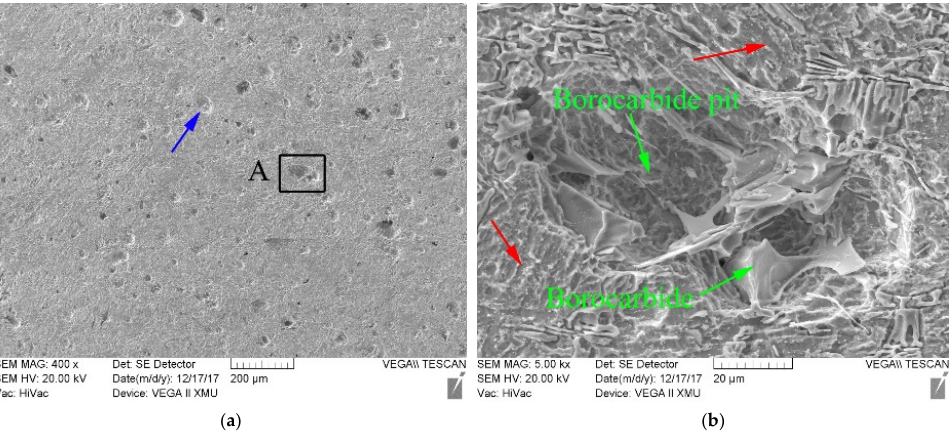
Figure 7. Erosion–corrosion face morphology SEM of boron-bearing stainless steel sample under test condition of impingement angle 45°, and rotating speed 1200 rev·min − 1 : ( a ) displaying erosion–corrosion face morphology; ( b ) displaying the magnified microstructures of A area.